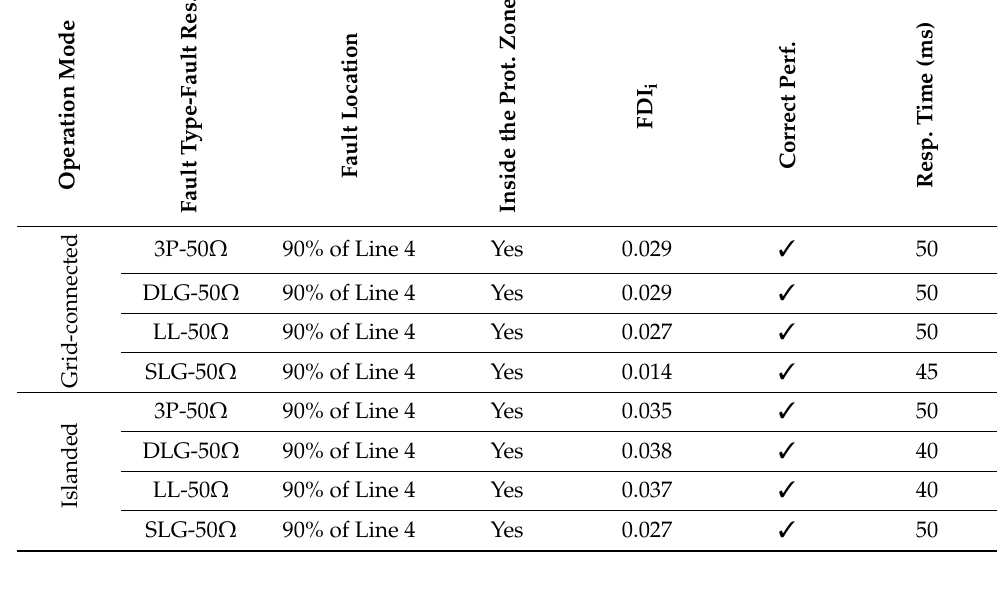
Table 5. Performance of the proposed main scheme in new pre-fault conditions.